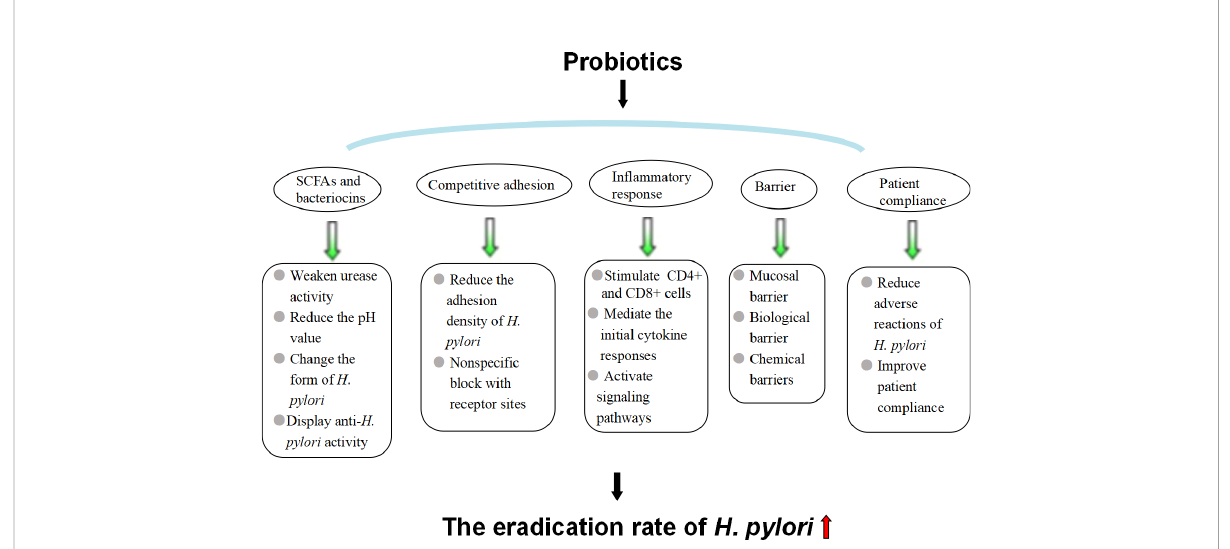
FIGURE 3 Mechanism by which probiotics improve the eradication rate of H. pylori.